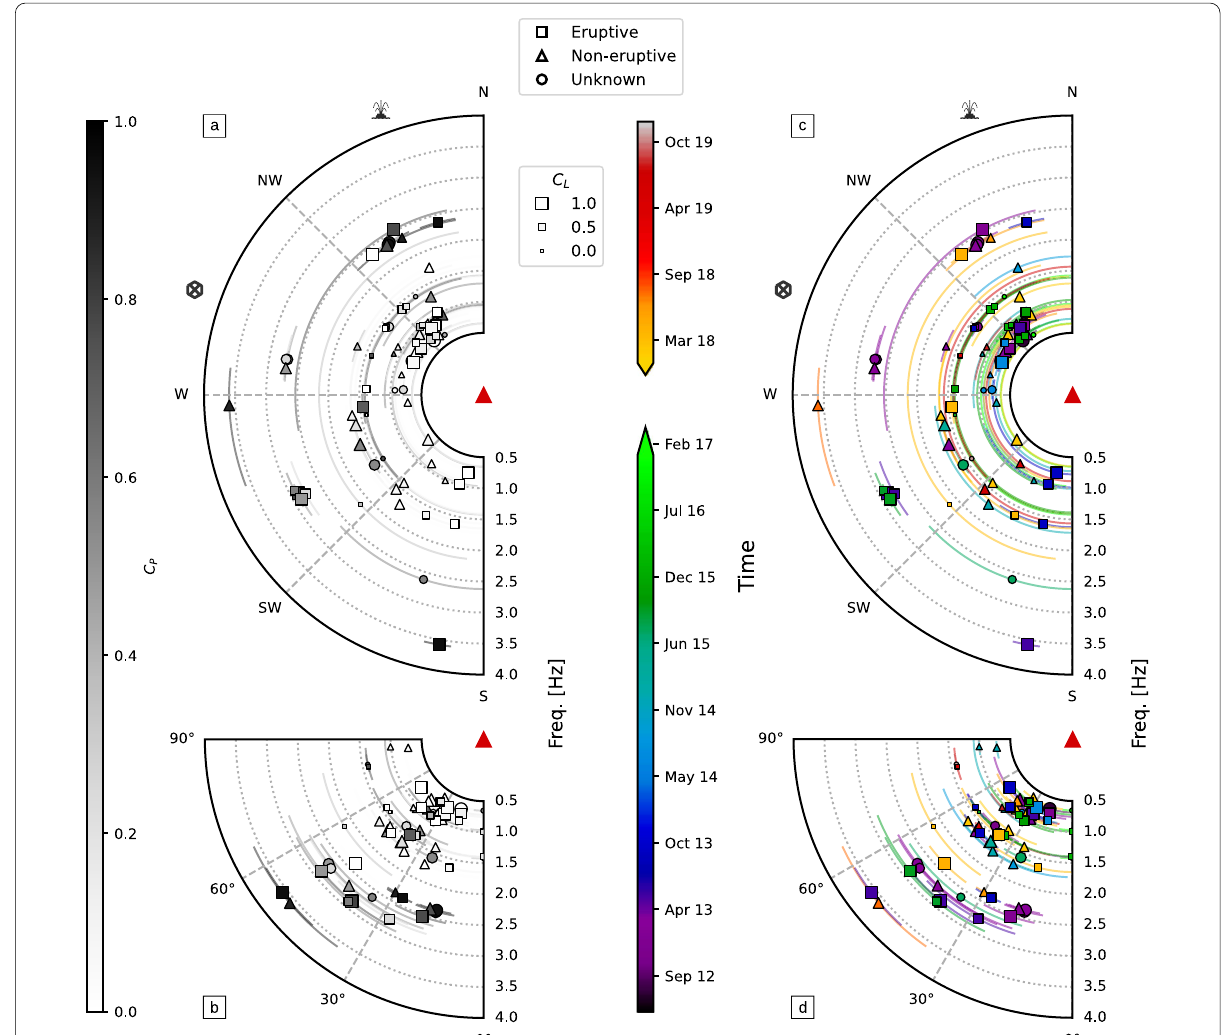
Fig. 13 Polarization attributes in frequency for all dominant peaks of NB tremors. (up) Horizontal azimuth (down) vertical incidence according to definition in Fig.